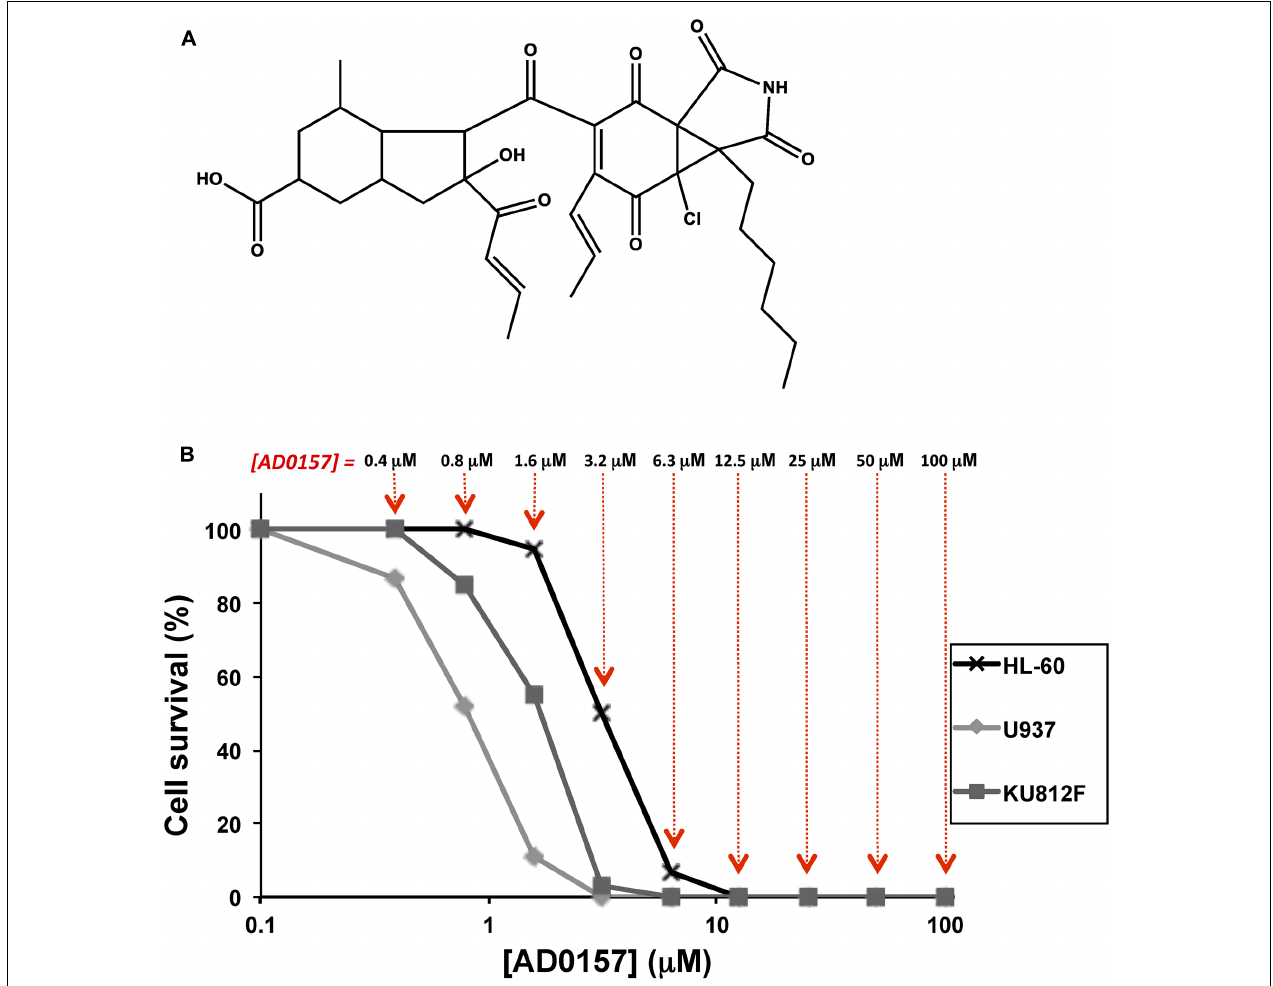
FIGURE 1 | AD0157 inhibits the growth of human myeloid leukemia cells. (A) Chemical structure of AD0157. (B) Representative survival curves with the dose-dependent effect of AD0157 on the in vitro growth of HL60 (x), U937 ( (cid:117) ) and KU812F ( (cid:4) ). Cell survival is represented as a percentage of control-cell growth in cultures containing no drug. Each point represents the mean of quadruplicates; SD values were typically lower than 10% of the mean values and are omitted for clarity. The different AD0157 concentrations are displayed at the